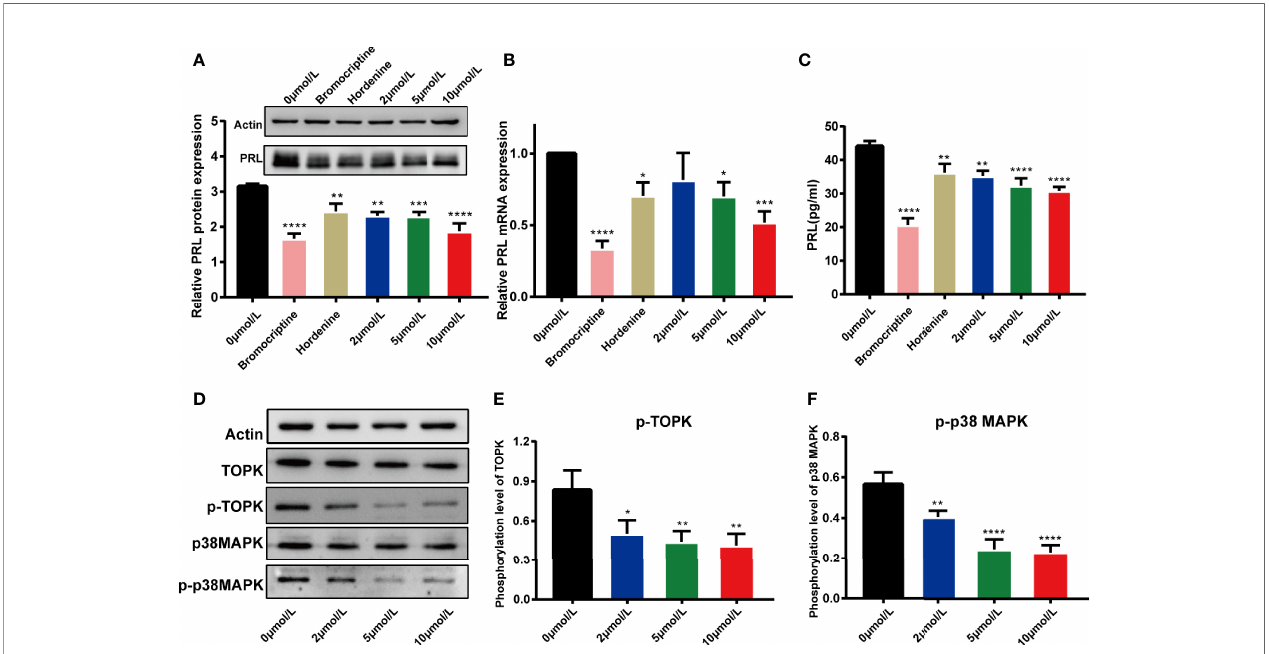
FIGURE 2 | HI-TOPK-032 reduced PRL production in pituitary tumor cells and it worked by mediating p38 MAPK signaling pathway. (A) HI-TOPK-032 decreased PRL protein expression in pituitary tumor cells detected by Western Blot assay. (B) HI-TOPK-032 decreased PRL mRNA expression in pituitary tumor cells detected by qRT-PCR assay. (C) HI-TOPK-032 decreased PRL secretion in cell supernatant detected by Elisa assay. (D) The expressions of TOPK, p38 MAPK and its phosphorylation level in pituitary tumor cells after HI-TOPK-032 intervention were detected by Western Blot assay. (E) HI-TOPK-032 reduced the phosphorylation of TOPK. (F) HI-TOPK-032 reduced the phosphorylation of p38 MAPK. * P < 0.05; ** P < 0.01; *** P < 0.001; **** P <